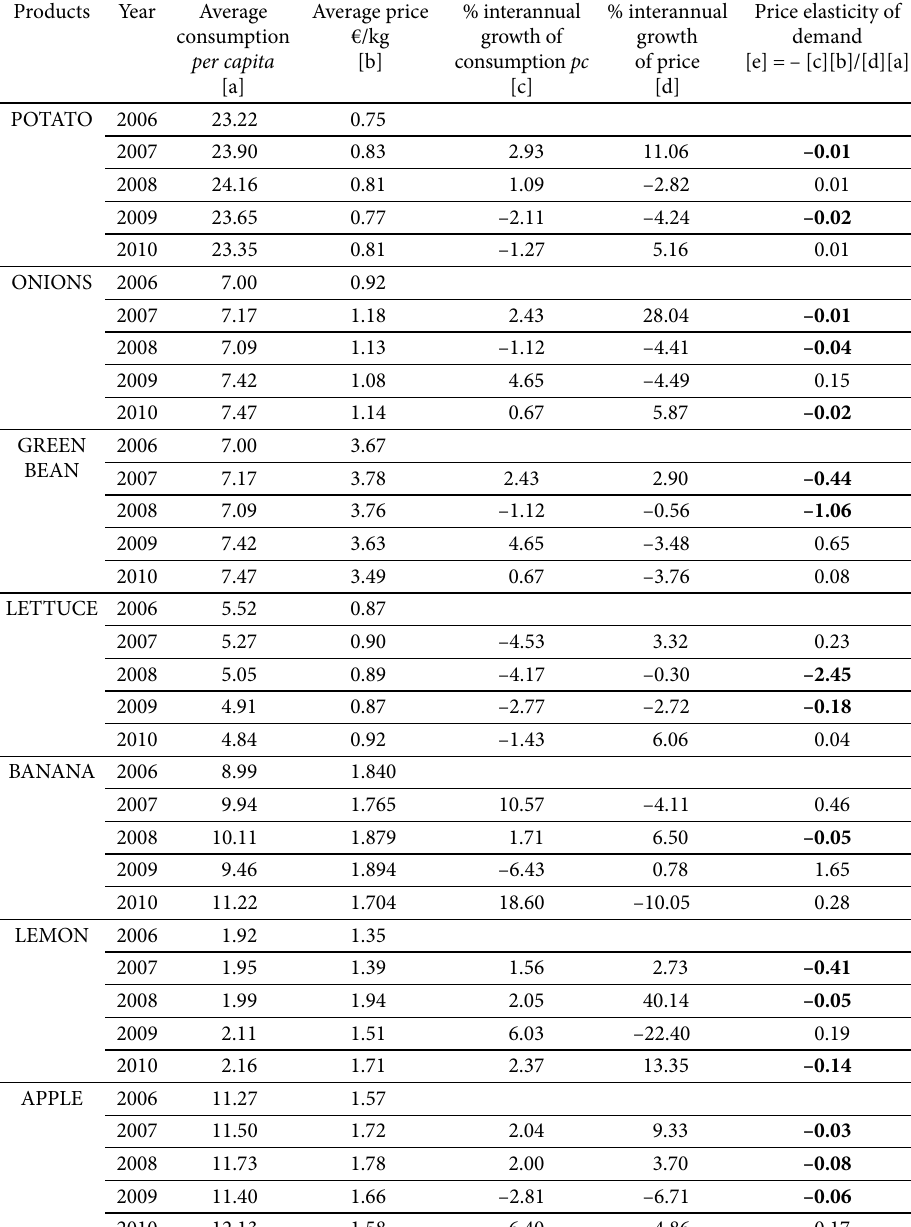
Table 6. Aggregate demand behaviour in Spanish vegetables and fresh fruits (2007–2010)